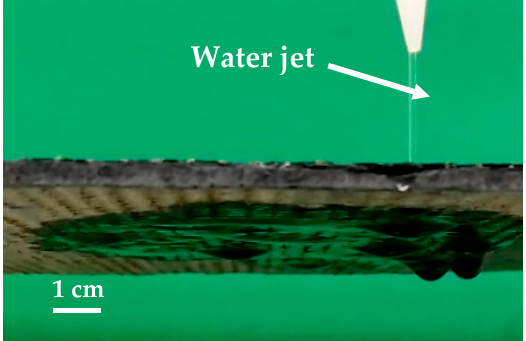
Figure 8. Images of the ( a ) entrance surface and ( b ) exit surface of a slate tile where 4082 holes were laser drilled under optimized processing parameters.